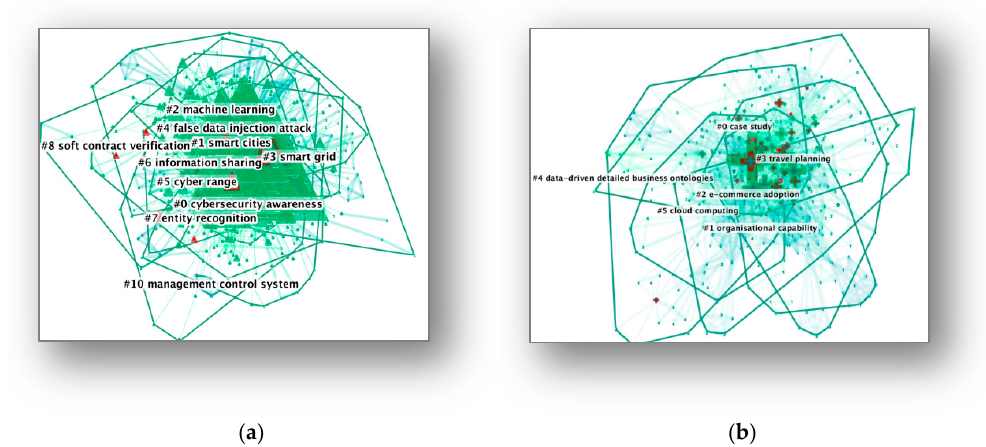
Figure 7. Comparative analysis by cluster mapping (keyword node): ( a ) clusters for cybersecurity; ( b ) clusters for electronic commerce. Both seem to represent major areas in each network; therefore, a detailed analysis by keyword nodes was performed for further analysis of cybersecurity knowledge. The top keywords are shown in Table 8. Table 8. Top keywords for cybersecurity research line. Keywords